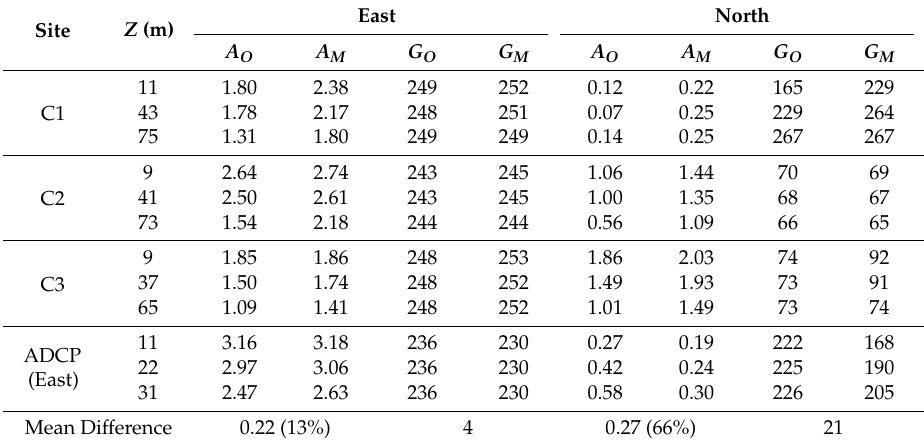
Table 5. Observed (subscript O) and modelled (subscript M) amplitude ( A , m · s − 1 ) and phase ( G , ◦ relative to UTC) of the east and north components of tidal velocity for the M 2 tidal constituent. Results are presented for near-surface, mid-depth and near-bed bins, with the relevant depth, Z (m), noted for each.